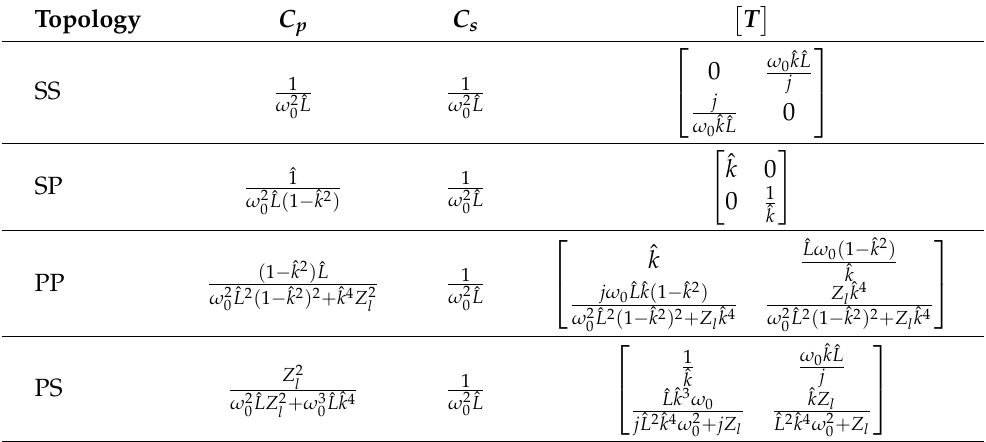
Table 1. Common values for primary compensation capacitors and their resulting transmission matrices at resonance ( ω = ω 0 ).